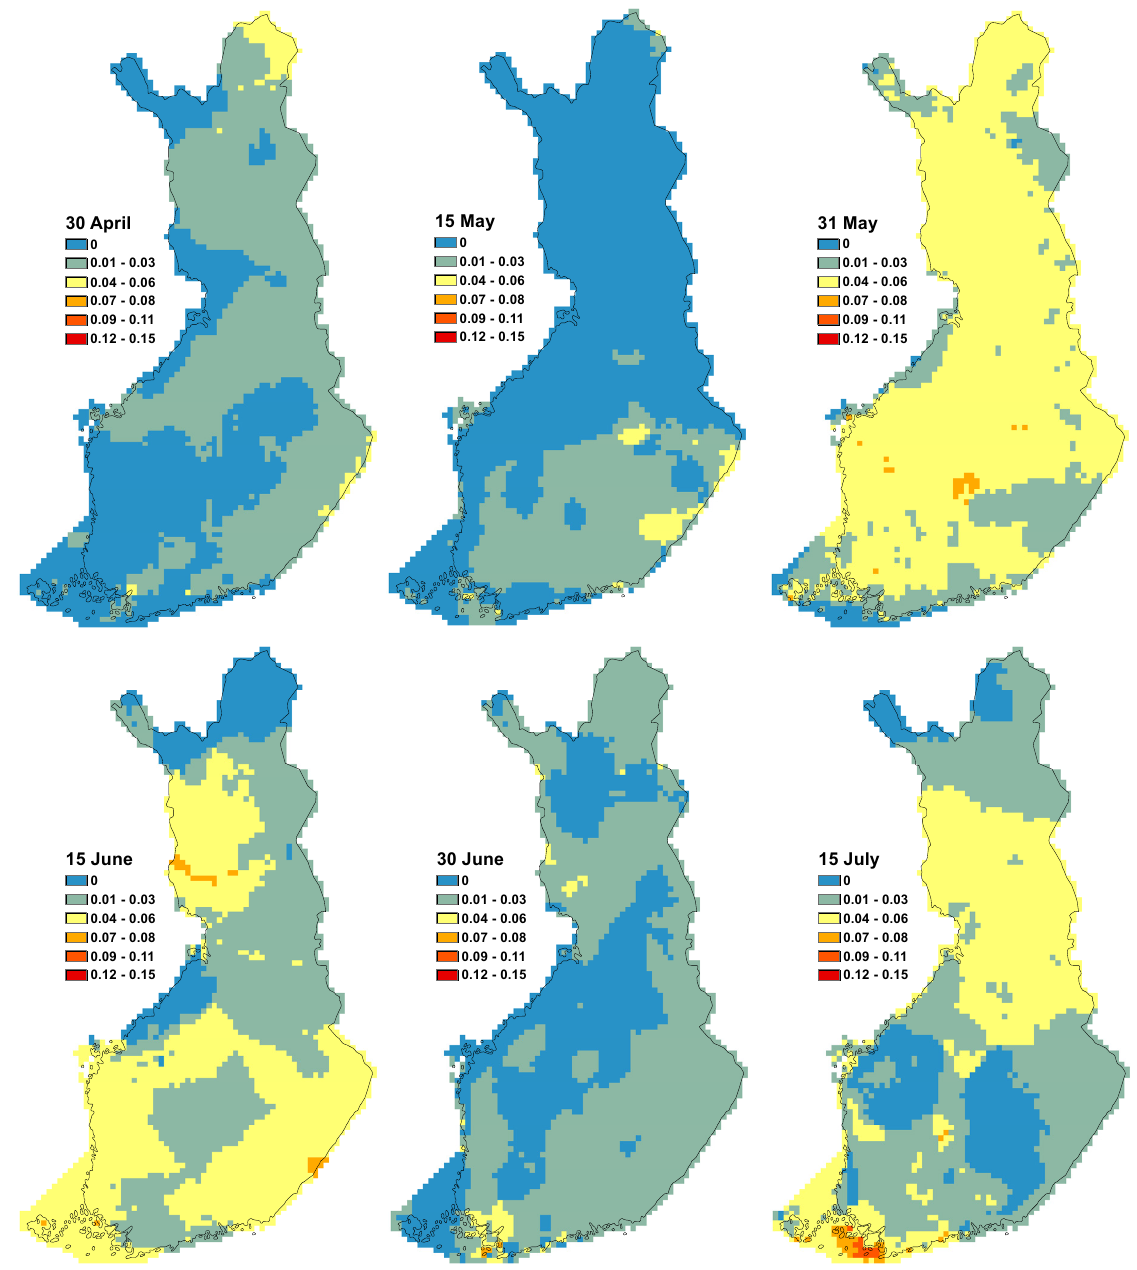
Fig. 2a. Probabilities of elevated temperatures of ≥2 °C that lasted for at least two weeks for the periods that ended on 30 April to 15